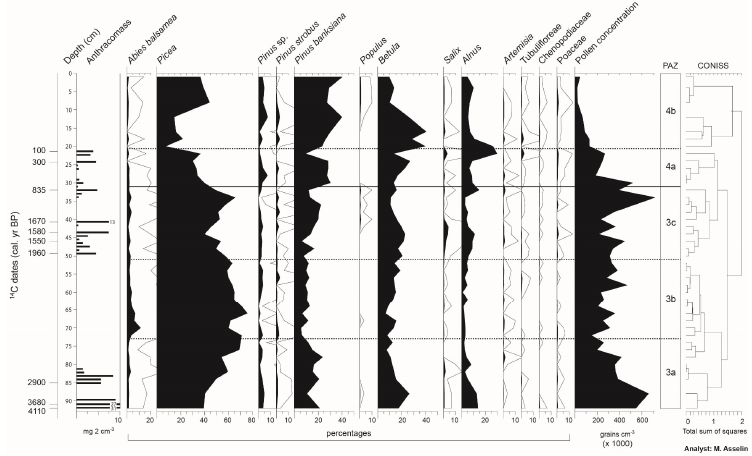
Figure 7. Pollen diagram (percentages; selected taxa) and charcoal content (mg · 2 cm − 3 ) of the sedimentary core collected at Shadow peatland. Open curves show a 10× exaggeration.